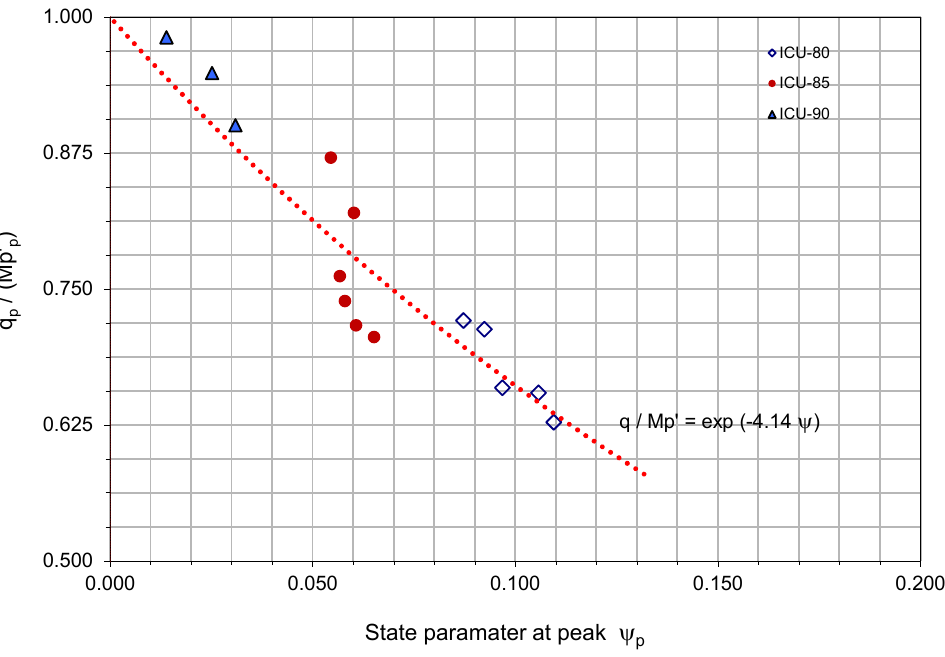
Figure 6. Peak state stress ratio as a function of state parameter.